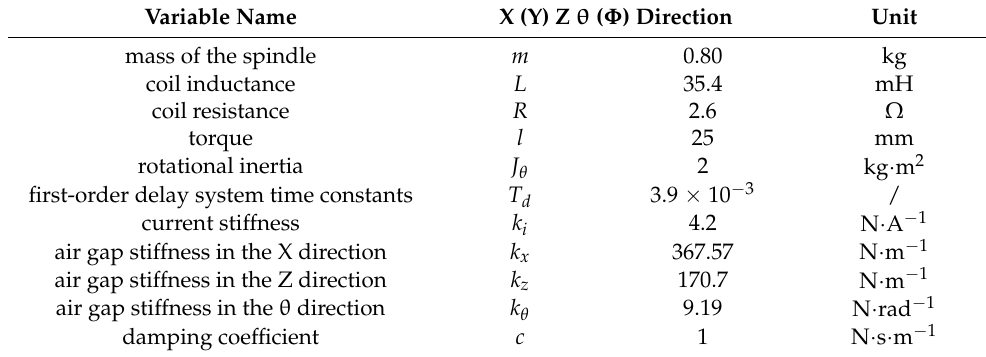
Table 1. Model parameters.